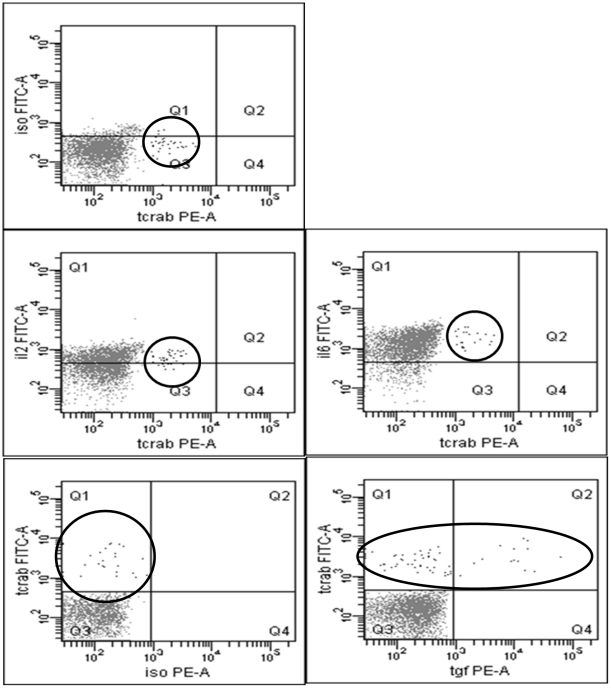
FACS plots showing the cytokine production in the TCR-αβ positive and negative subset.FACS plots showing IL-2 and IL-6 production in-vivo. The black circles identify the TCR-αβ positive population. In this sample, the TCR-αβ positive cells comprised 2% of the PDC population and partly produced TGF-β. TGF-β secretion was analysed four times.